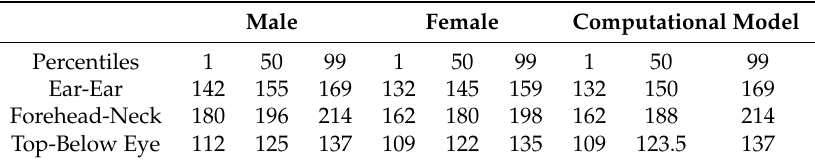
Table 1. Head size data of the American male and female populations (in mm) presented with their 1st, 50th, and 99th percentiles; the data are reprinted from [30]. The head size data used for this study were obtained by adding the two distributions for men and women, and the resulting percentiles are shown in the three columns labeled “computational model”. Male Female Computational Model Percentiles